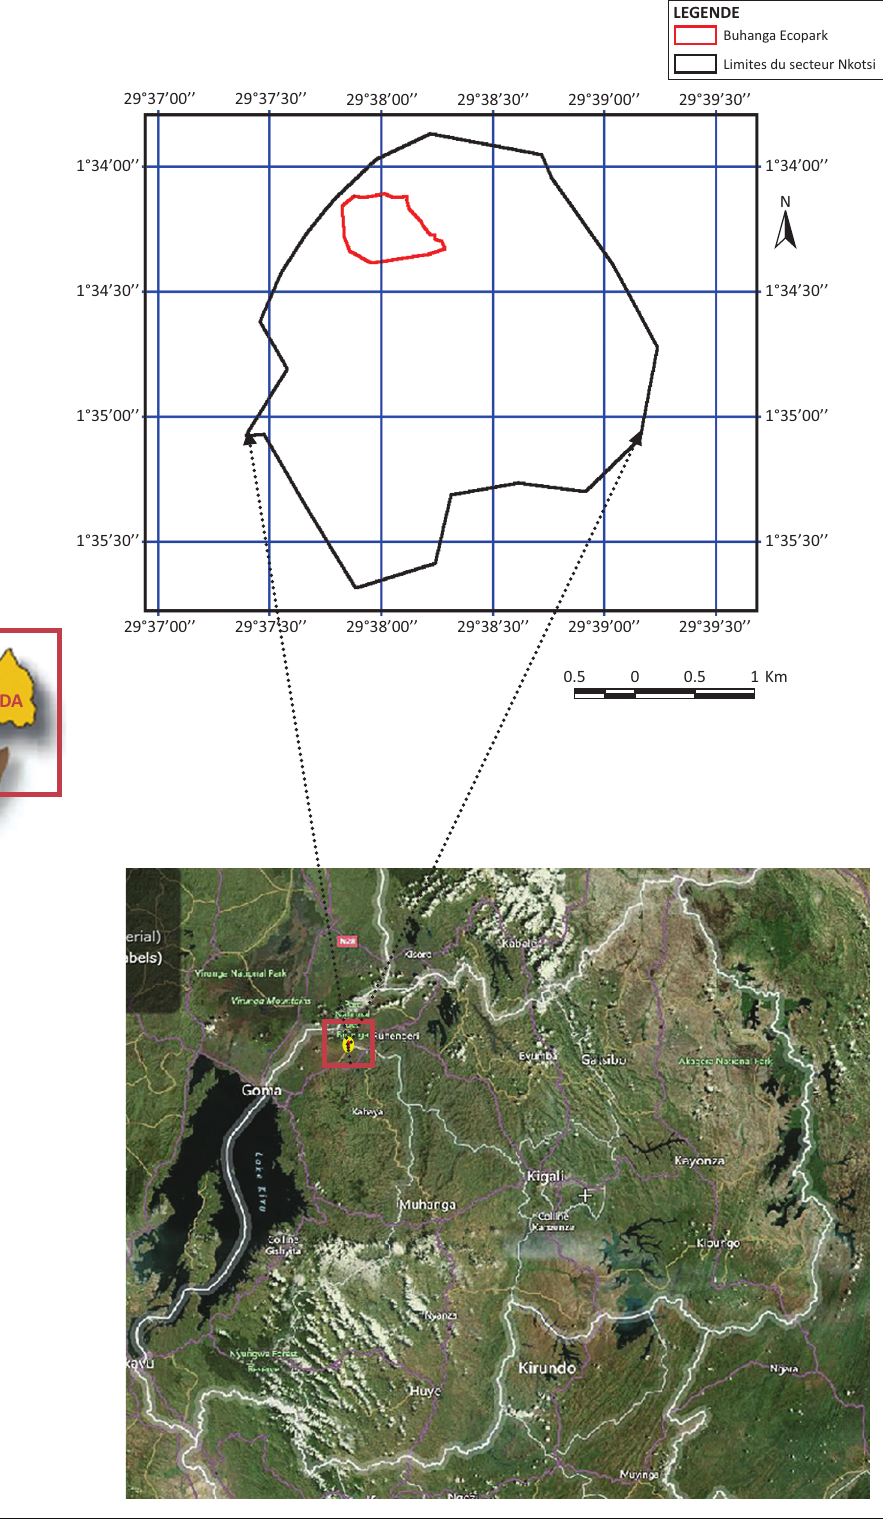
FIGURE 2: Map of the study